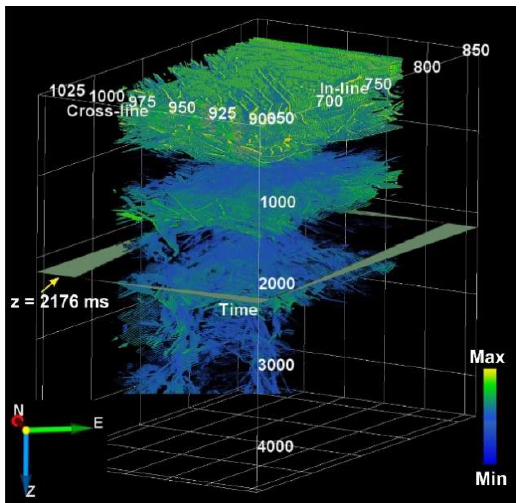
Figure 7. Thinned-fault likelihood (TFL) cube showing the discontinuities in the study area. The inserted slice at z = 2176 ms shows the presence of small scale fractures compared to the top, where large scale fractures were present.